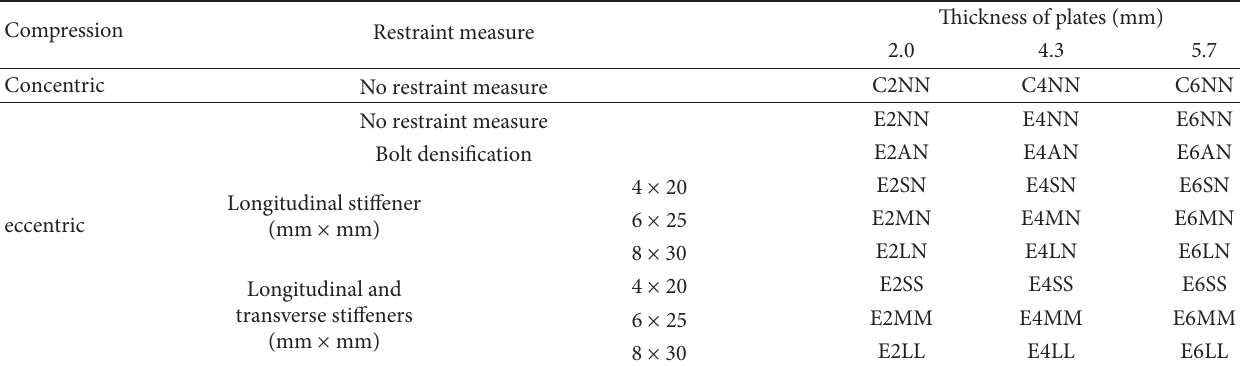
Table 5: Information of